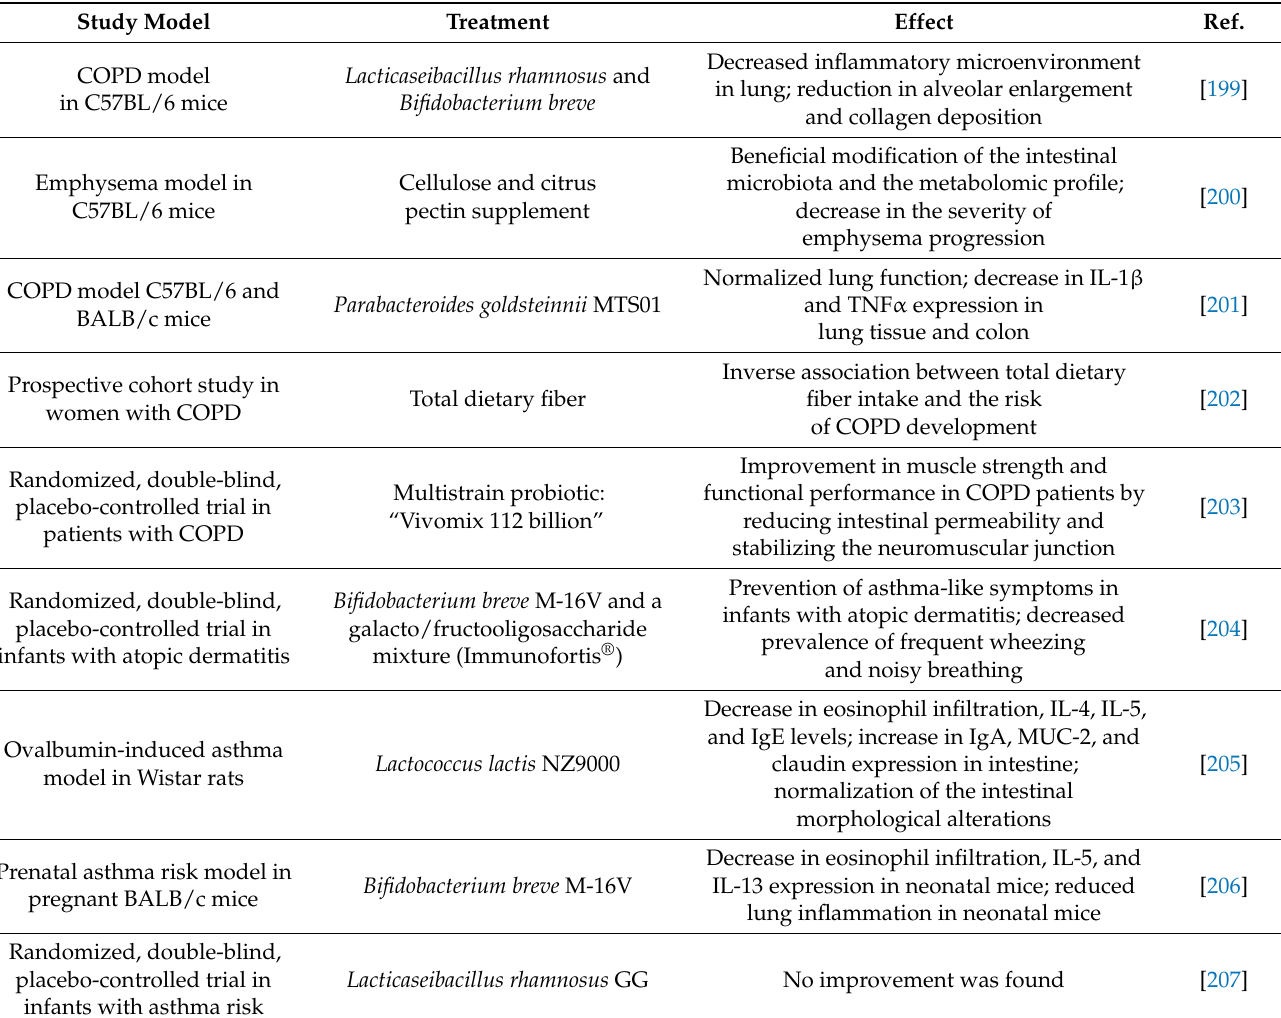
Table 3. Effect of probiotics and prebiotics in mouse models and clinical trials in lung